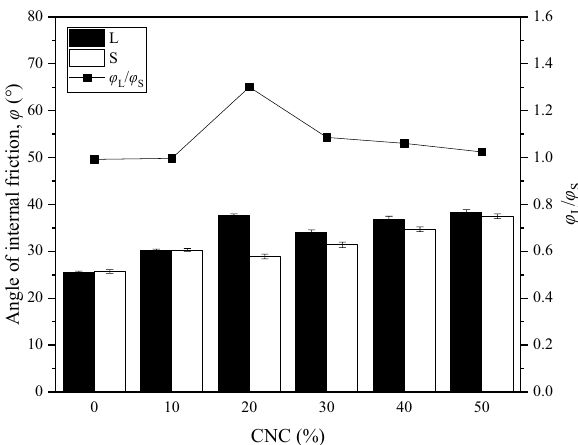
Figure 7. Relationship between the angle of internal friction of CSCN samples and the CNC.